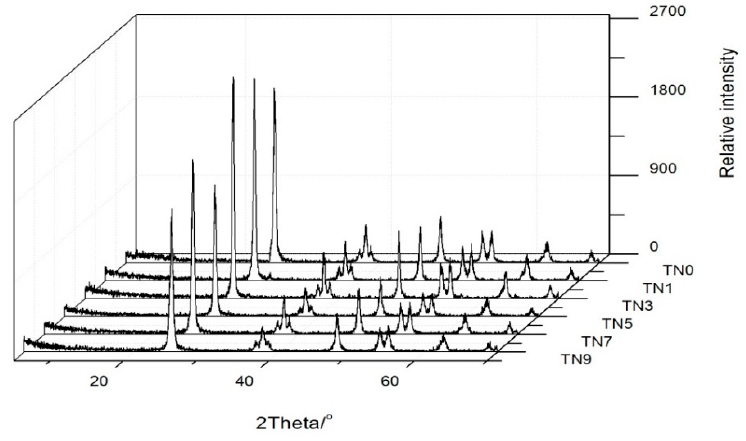
Figure 1. XRD patterns of TN0, TN1. TN3, TN5, TN7 and TN9.